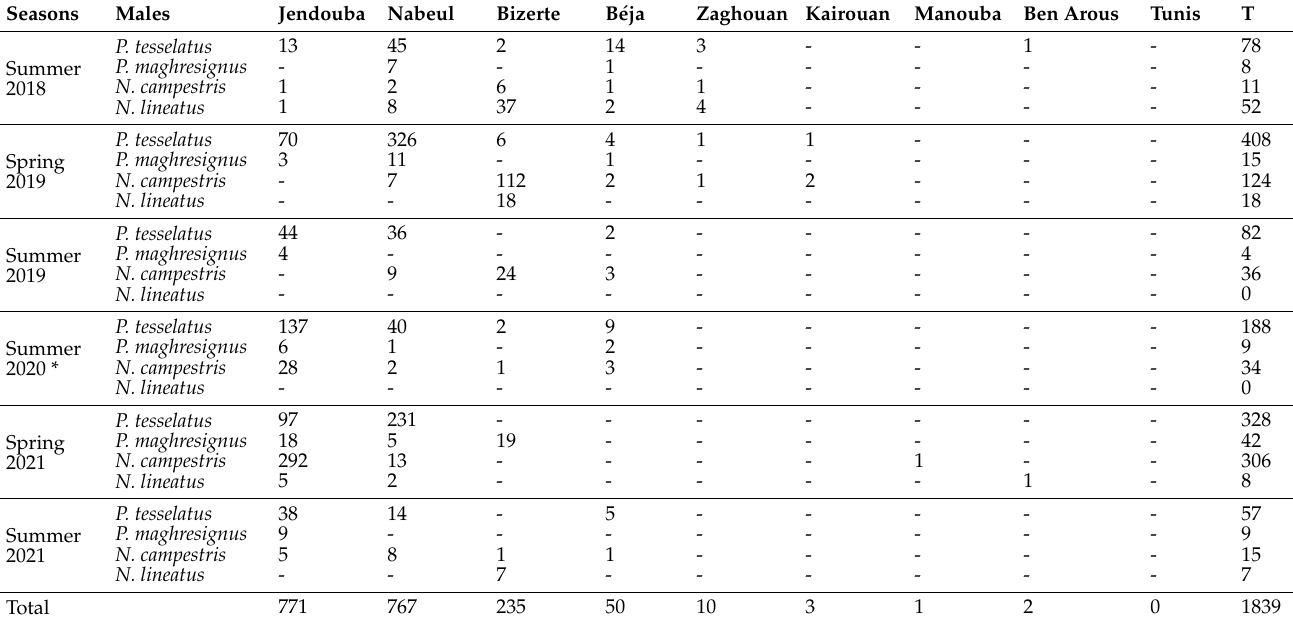
Table 2. Aphrophoridae species frequency (number of specimens) collected by sweep netting in Tunisia,